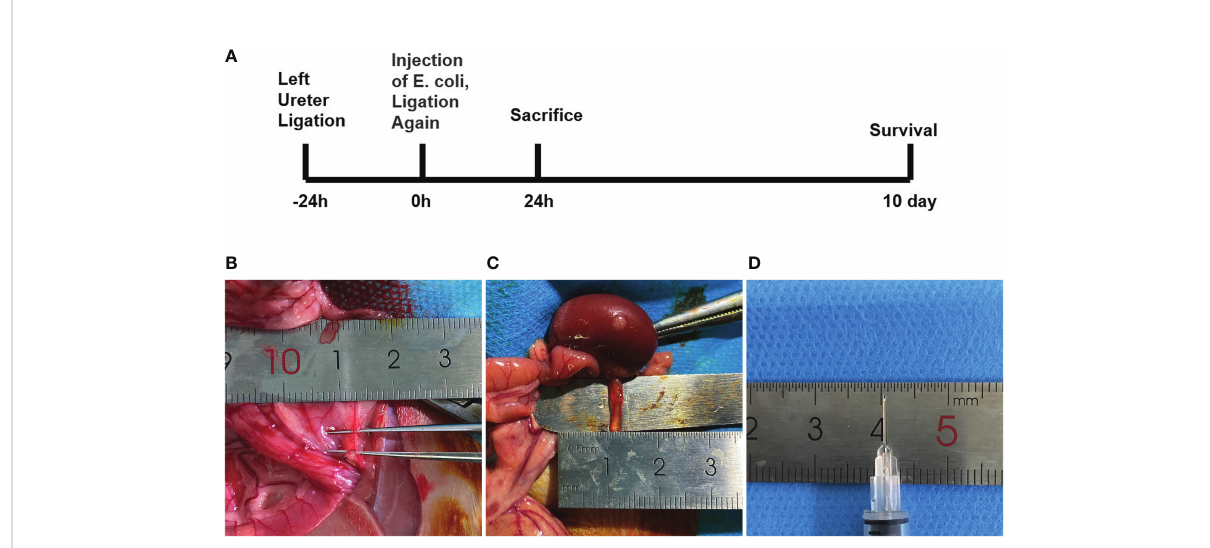
FIGURE 1 The experimental procedure and critical steps in the process of urinary sepsis model in rats. (A) Schematic diagram of the experimental procedure. (B) The ureter prior to ligation. (C) Dilated ureter after ligation for 24h. (D) 30G syringe